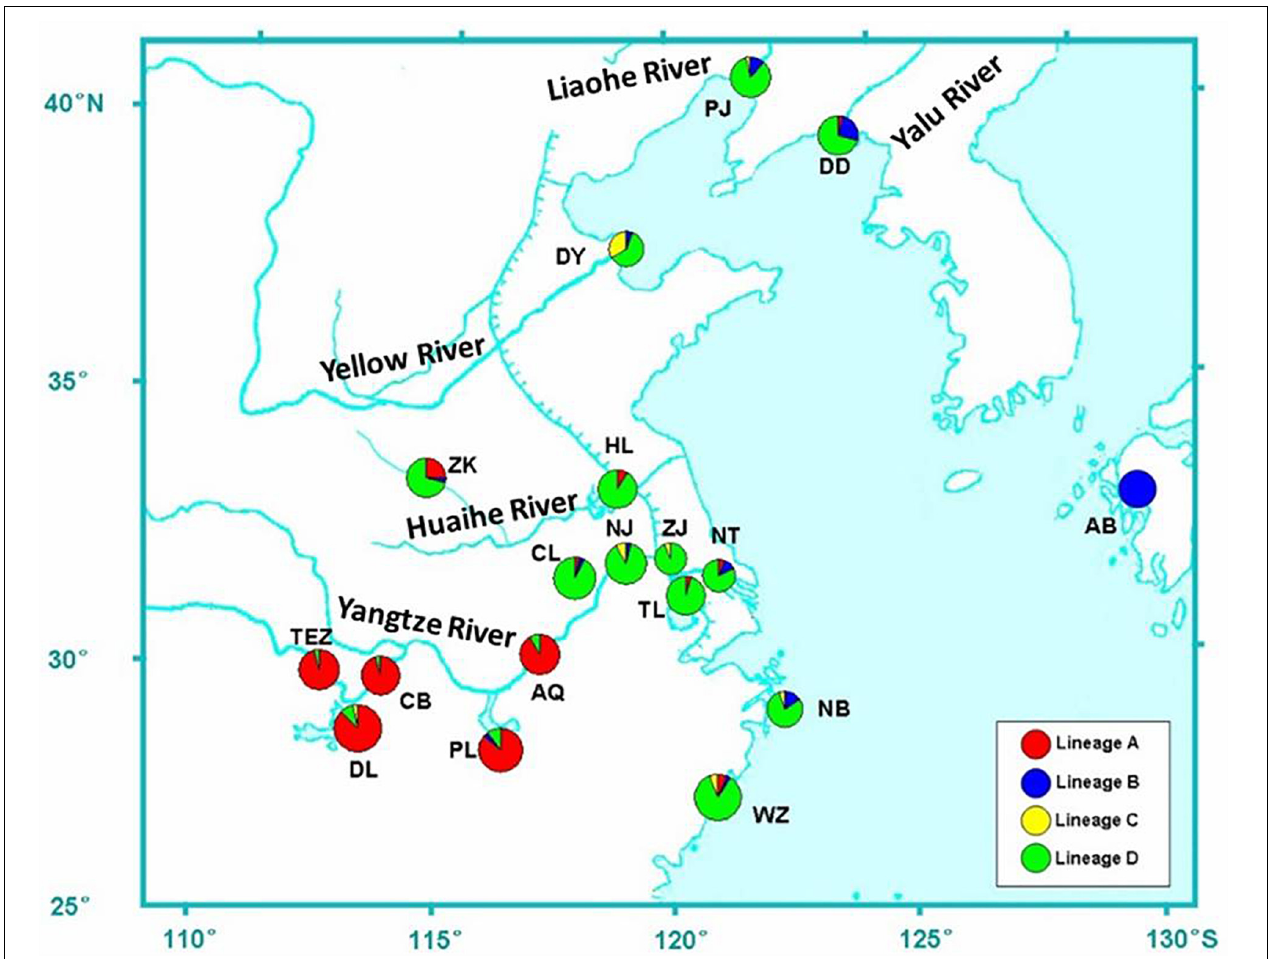
FIGURE 1 | Sample locations of C. nasus . Populations are marked by abbreviations that correspond to Table 1 . Pie charts show the frequencies of lineages A, B, C, and D (see results for determining the four